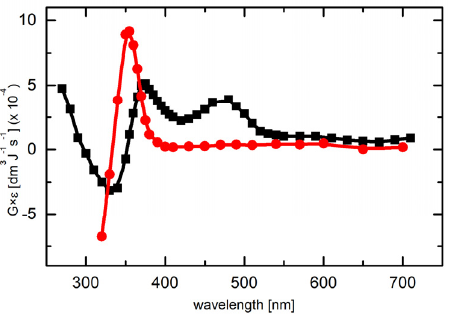
Figure 2. Transient absorption spectra recorded in aqueous solutions containing 0.1 mM 3 ‐ MeQ at pH 7: ( ■ ) 10 μ s after the electron pulse in Ar ‐ saturated solutions containing 0.1 M K 2 S 2 O 8 and 0.5 M tert ‐ BuOH and ( ● ) 3 μ s after the electron pulse in N 2 O ‐ saturated solutions and containing 0.1 M NaN 3